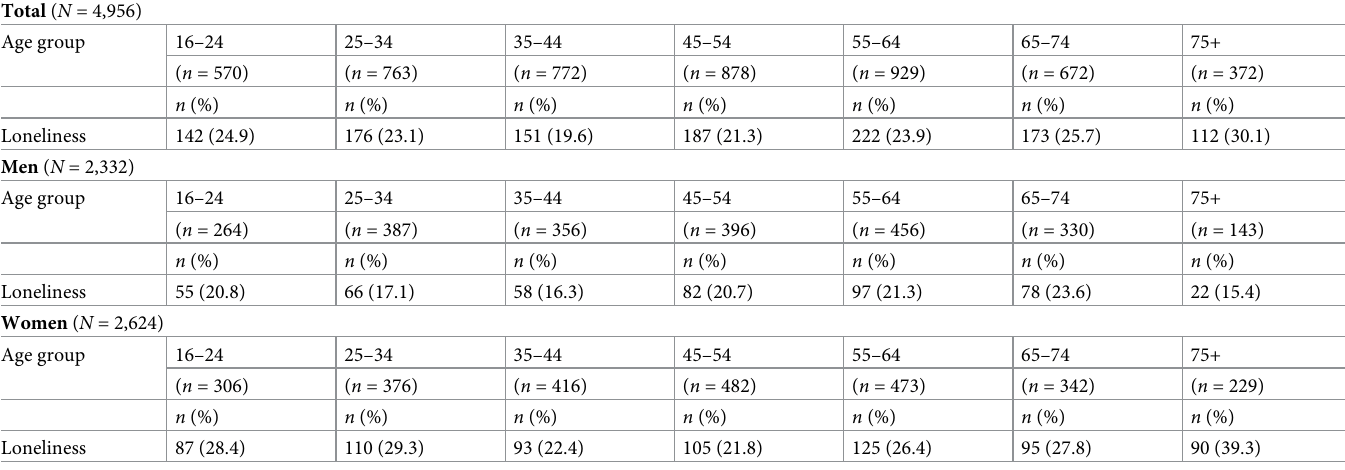
Table 2. Proportions of lonely individuals in the combined survey samples (assessed using the single-item measure), stratified by sex and age group.